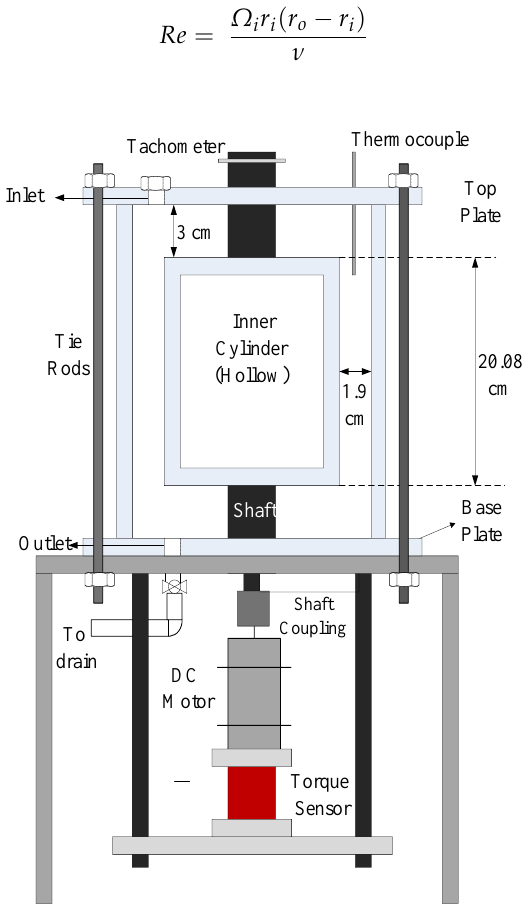
Figure 1. Schematics of Taylor–Couette Setup used in this study [18]. (Reproduced with permission from Wiley & Sons, Hoboken, NJ, USA).